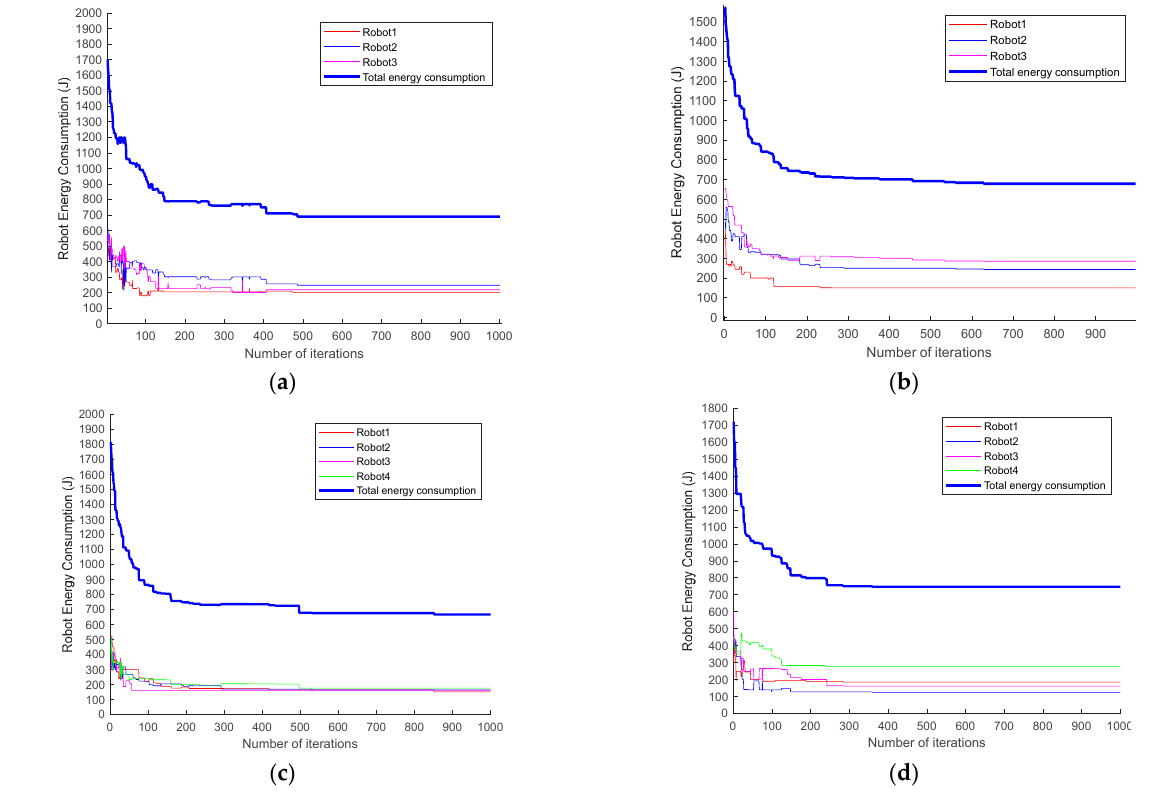
Figure 10. Iterative curve of robot energy consumption from Experiment 1: ( a ) algorithm in this paper ( m = 30, n = 3); ( b ) basic genetic algorithm ( m = 30, n = 3); ( c ) algorithm in this paper ( m = 30, n = 4); ( d ) basic genetic algorithm ( m = 30, n = 4).